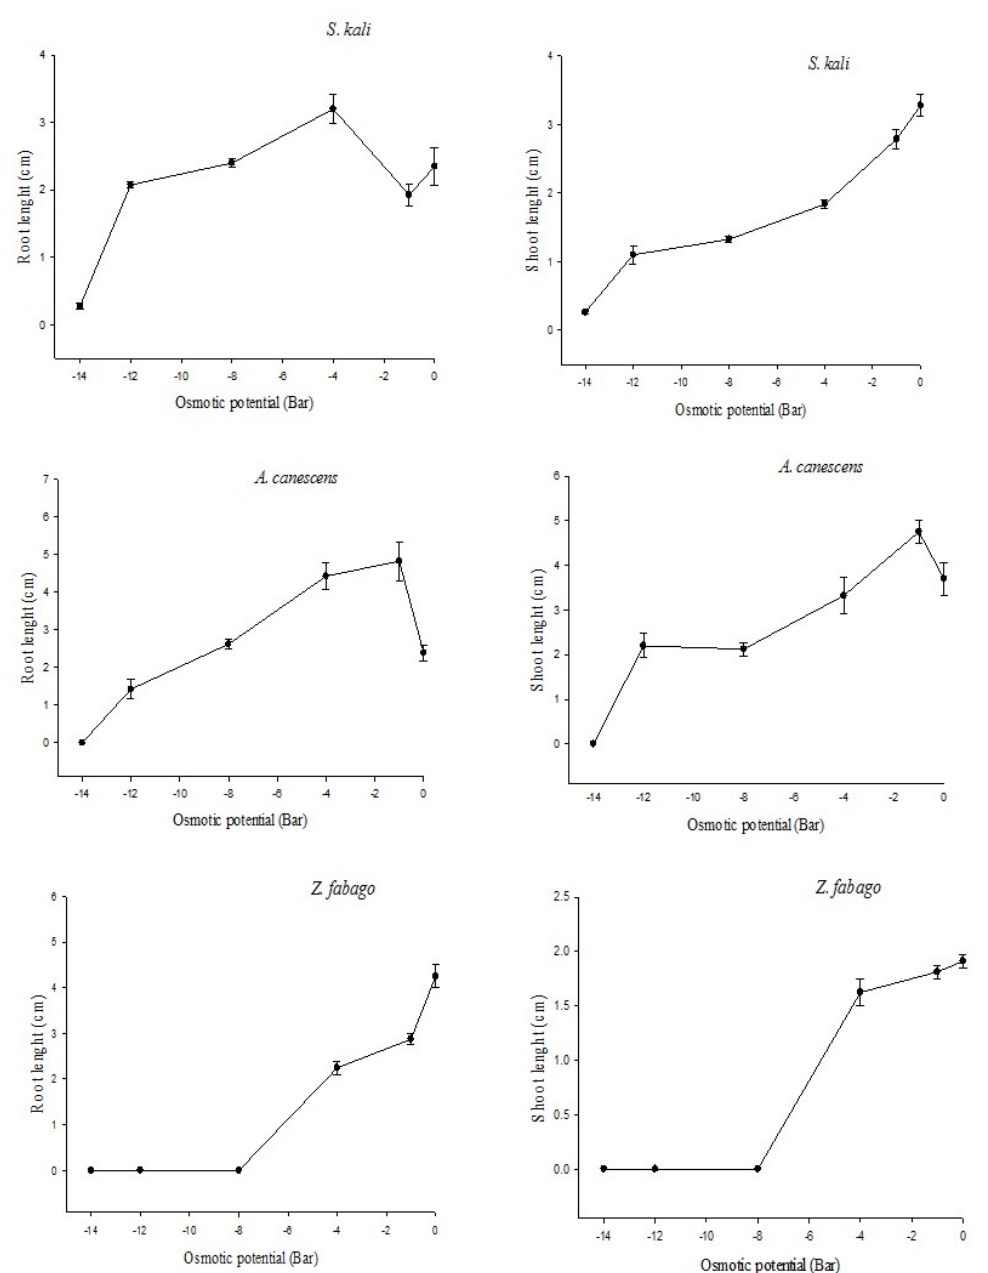
Figure 3. Root ( left ) and shoot length ( right ) of S. kali , A. canescens and Z. fabago under different PEG-6000 concentrations. Data represent means ( n = 4) ± SE.